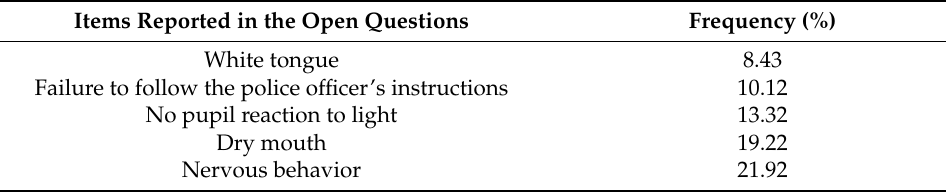
Figure 2. Dendrogram obtained by cluster analysis of the checklist items. Lines outline three groups of items, each of which forms a column in the redesigned VERIFY checklist (solid black line: first column; grey dashed line: second column; dashed black line: third column). Table 3. Frequencies of the most reported items found in the open